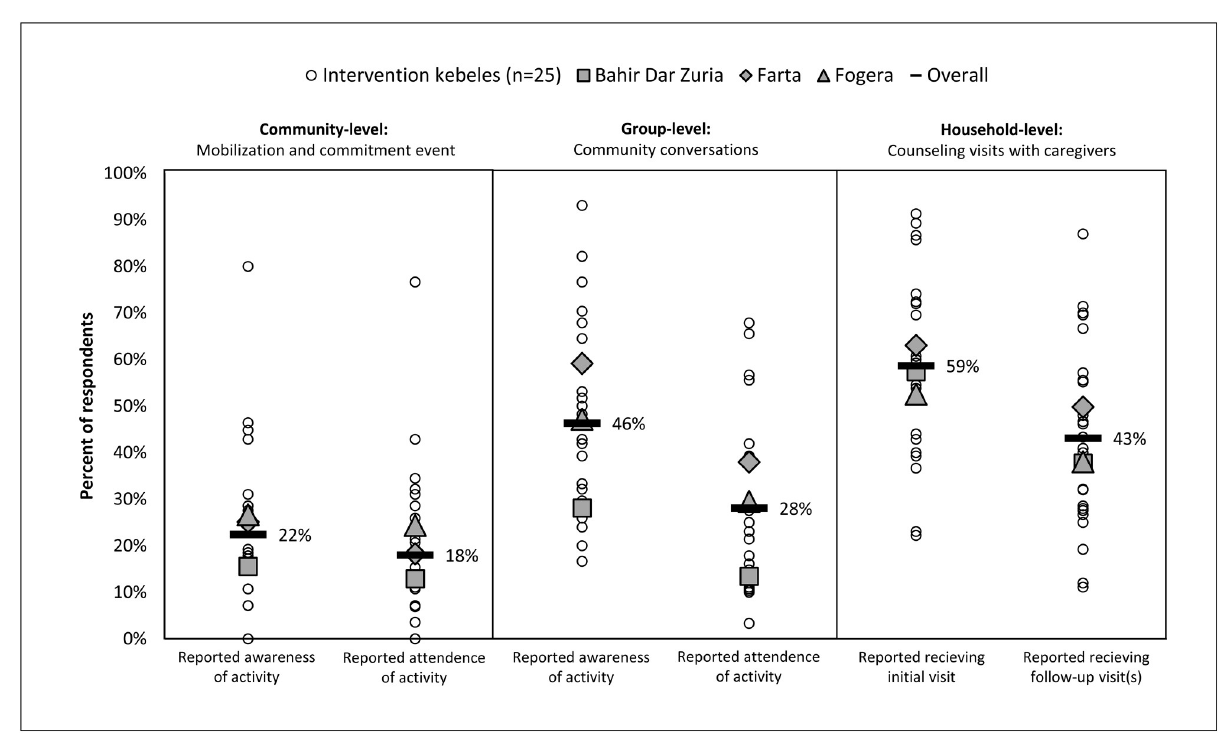
Fig 3. Respondent-reported exposure of key behavior change activities of the Andilaye intervention. Respondents from study-enrolled households in intervention kebeles (n = 793) were surveyed on their awareness and attendance in the community-level mobilization and commitment event during quarterly monitoring visits and awareness and attendance of group-level community conversations and frequency household-level counseling visits received by endline visits. A total of 703 (89%) and 707 (89%) surveys with responses to process evaluation prompts were completed from quarterly monitoring and endline, respectively. Reported frequency of counseling visits reflected a total of 665 survey responses as these questions were not relevant for study-enrolled households that were residents of caregivers who were trained as Women’s Development Army Leaders (WDALs) responsible for conducting the Andilaye counselling visits (n =